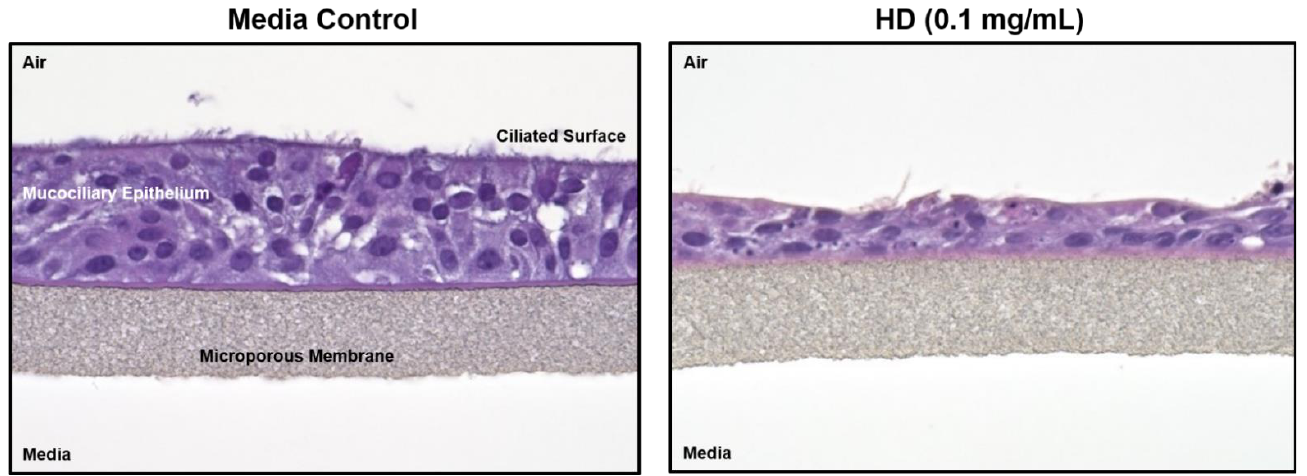
Figure 1. Histology changes associated with HD exposure in EpiAirway TM tissues. Paraffin-embedded sections from EpiAirway TM tissues exposed to media or HD (0.1 mg/mL; 0.629 mM) were rehydrated and stained with hematoxylin and eosin.